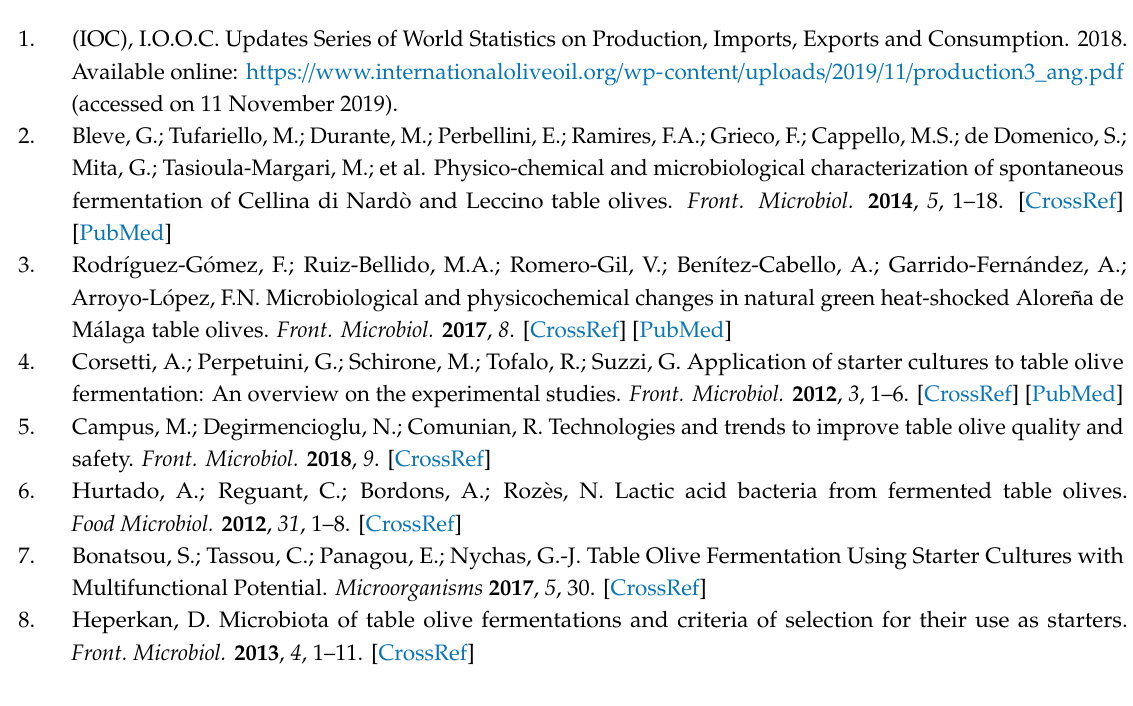
Supplementary Table S1: Evolution of color parameters (a*, b*, L*, h*, and C*) of olive fruits during spontaneous (OL7), inoculated (10% NaCl) (OL8), and inoculated (7% NaCl) (OL9) fermentation of Cypriot green cracked table olives. Data points are expressed as means and standard deviations of 10 random measurements. Supplementary Table S2: Contribution of all studied variables to the factors in the PCA based on